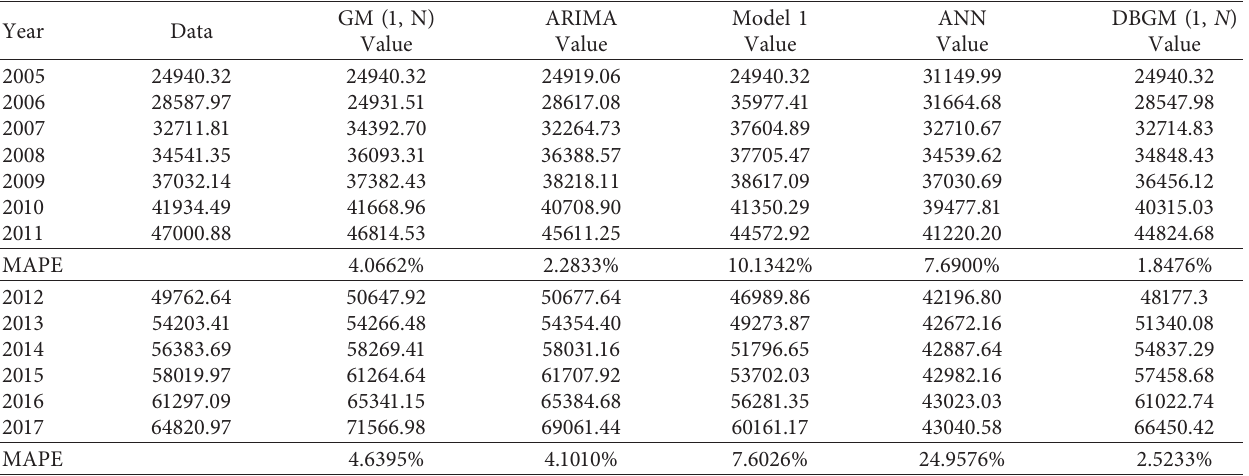
Table 2: The predicted values and APEs of the GM (1, N ) model, Model 1, and DBGM (1, N ) model in Case 1. Year Data